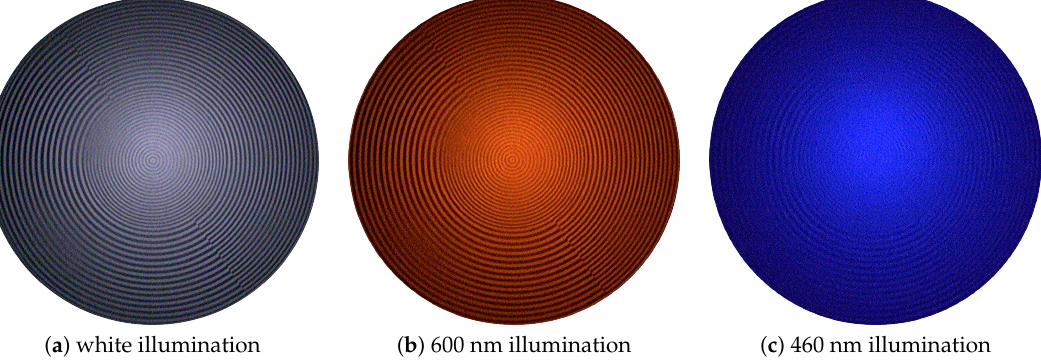
Figure 6. These images show multispectral filter-wheel acquisitions scanning the central circle pattern of the sharpness indicator by Putora [44]. ( a ) White light illumination and ( b ) 600 nm illumination: all circles are clearly visible, indicating a high degree of sharpness (DS) of 108.9 lp/mm; ( c ) 460 nm illumination: only thickest lines are visible with a computed DS of 62.3